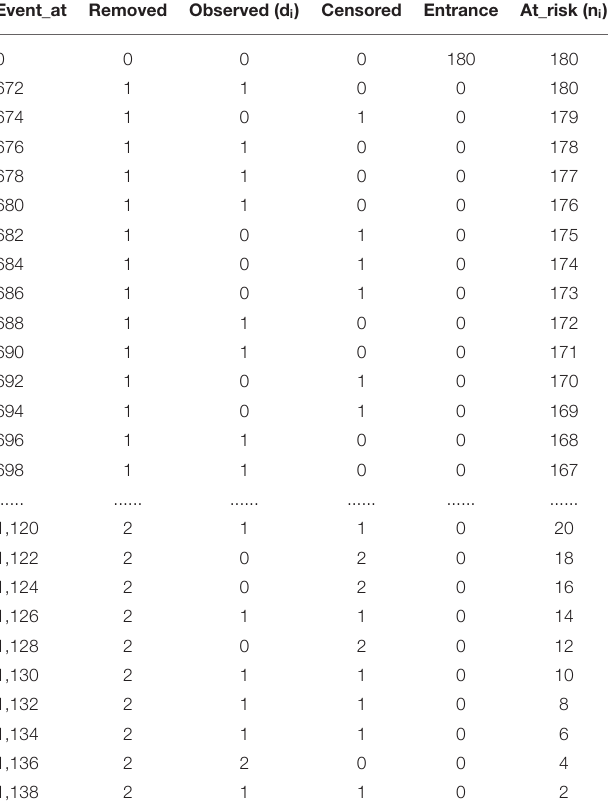
TABLE 15 | Event table for male. Event_at Removed Observed (d i ) Censored Entrance At_risk (n i )